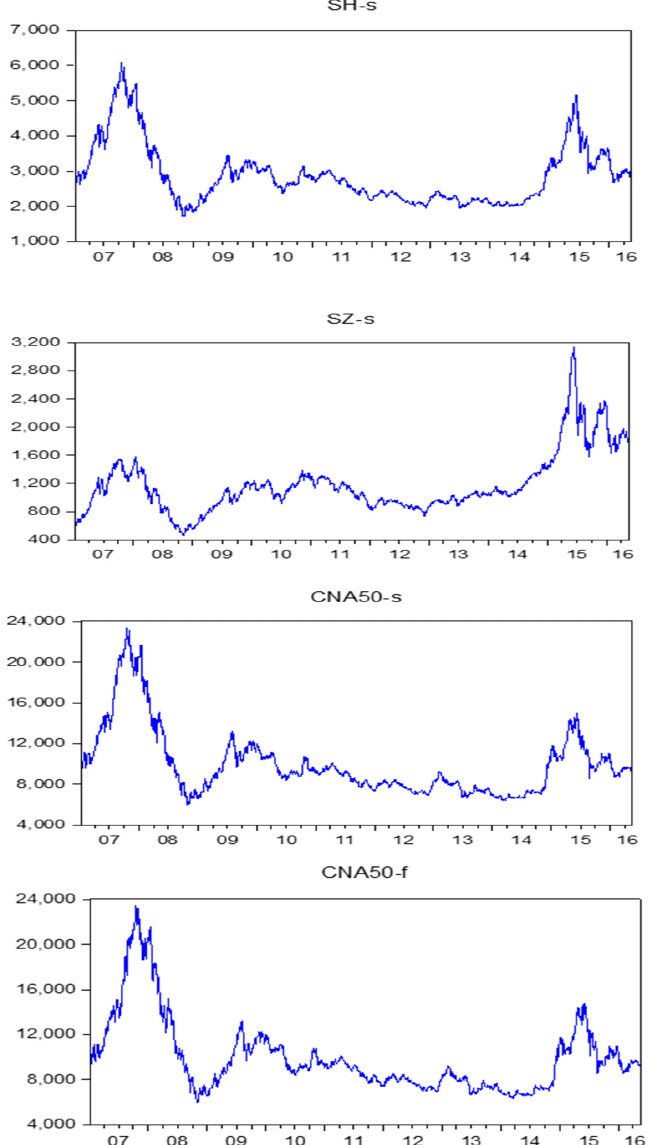
Figure 3. Spot prices of SSE Composite, SZSE Composite, China A50, and futures price of China A50, 2007–2016 (denoted 07–16).